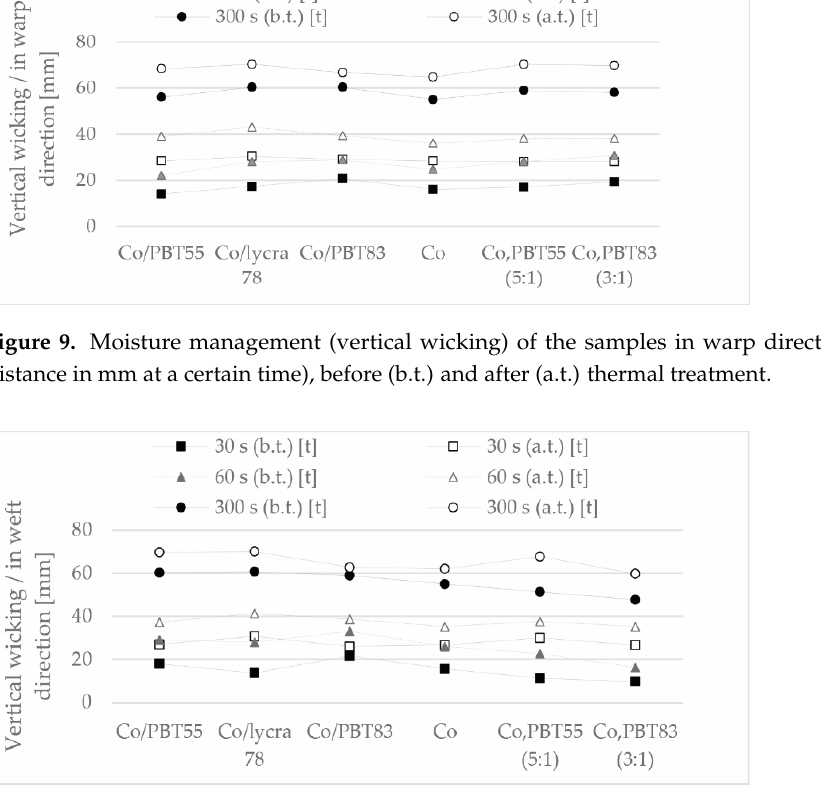
Figure 10. Moisture management (vertical wicking) of samples in the weft direction (measures distance in mm at a certain time), before (b.t.) and after (a.t.) thermal